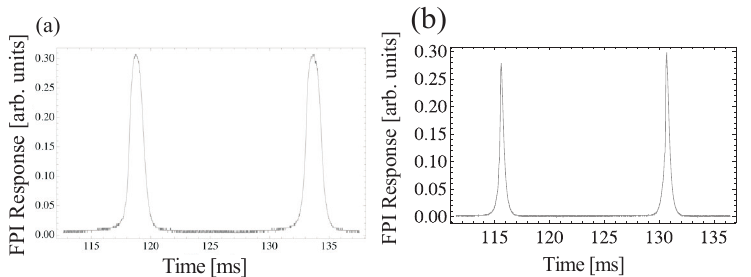
Figure 7. Transmission peaks obtained by operating the diode laser at a fixed frequency and scanning the Fabry-Pérot interferometer (FPI). ( a ) FPI peaks without grating feedback. The measured FWHM is 133 ± 5 MHz. ( b ) FPI peaks with grating feedback. The measured FWHM of 67 ± 3 MHz is comparable to the calculated resolution of the FPI. The value of the free spectral range of the spherical mirror FPI (c/4L), calculated on the basis of the known cavity length of L = 7.5 cm is ∼ 1 GHz. Since the separation between adjacent transmission peaks is equal to the free spectral range, it is possible to convert the time axis into frequency